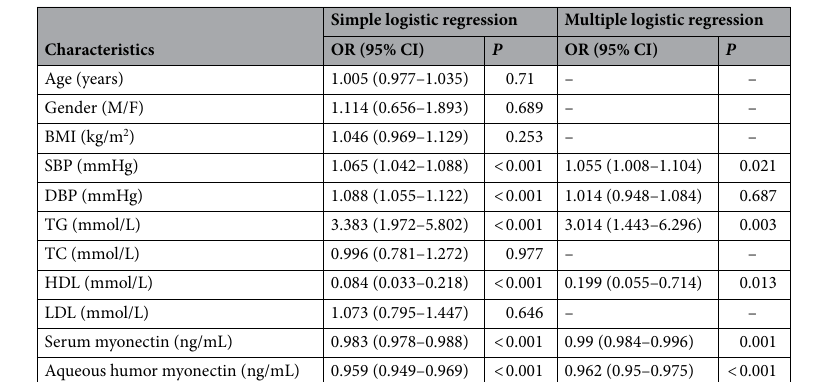
Table 2. Logistic regression analysis for determining the risk factors of developing T2DM. Abbreviation as Table 1. Univariate logistic regression analysis was performed and the variables with a P < 0.05 were then entered into a multivariate logistic regression model to assess the significant independent factors associated with T2DM.